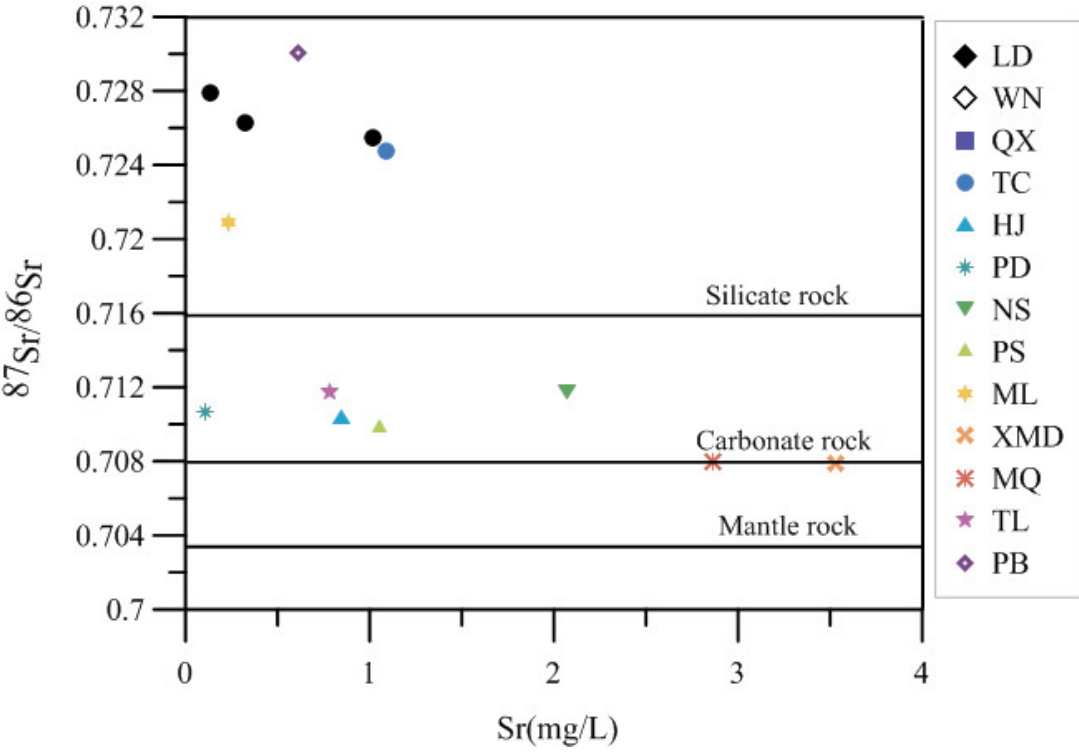
Figure 8. Strontium isotopic composition of the 20 hot springs in the study area.